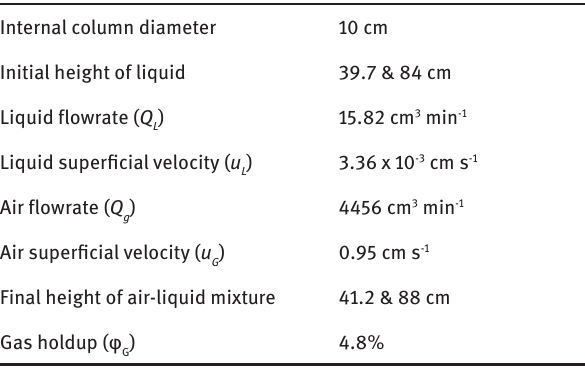
Table 1: Experimental conditions of the RTD